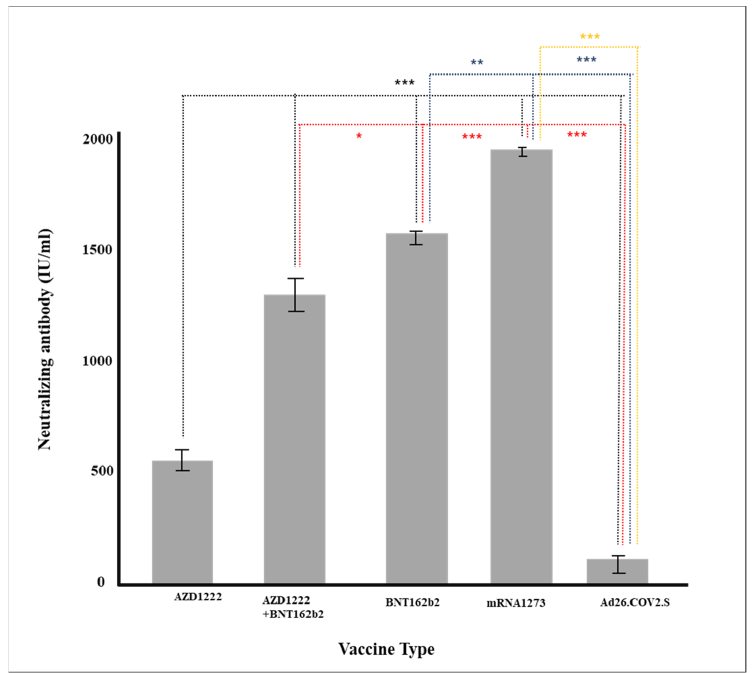
Figure 1. Production of neutralizing antibody according to vaccine (* p < 0.05, ** p < 0.01, *** p < 0.001).